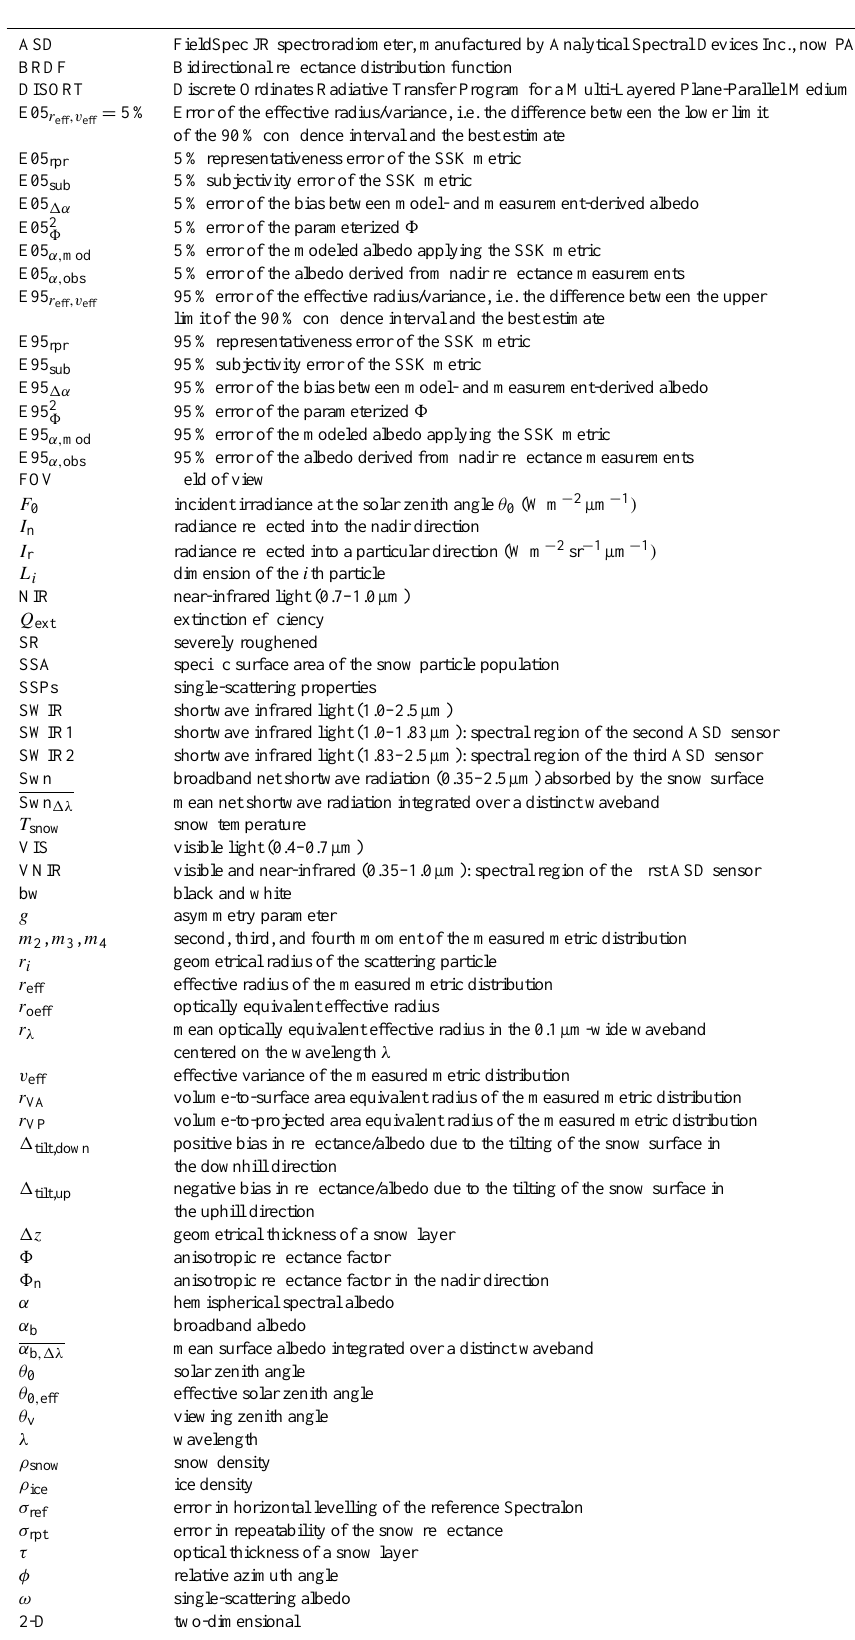
Table A1. List of acronyms and symbols.